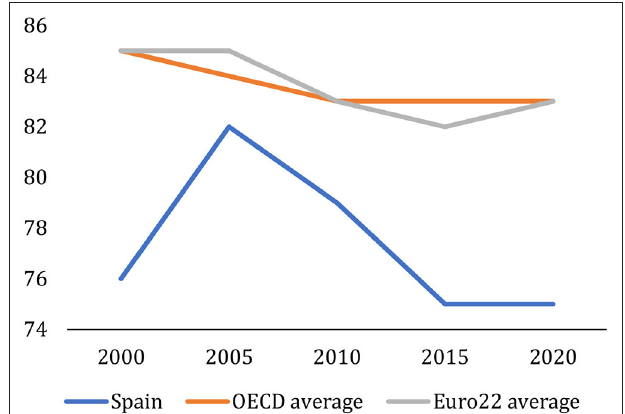
FIGURE 10 | Trends in employment rates. Tertiary education. Percentage of 25–34 year-olds employed in this age bracket. 2000, 2005, 2010, 2015, and 2020. OECD indicators, Education at a Glance (OECD, 2017, 2021).